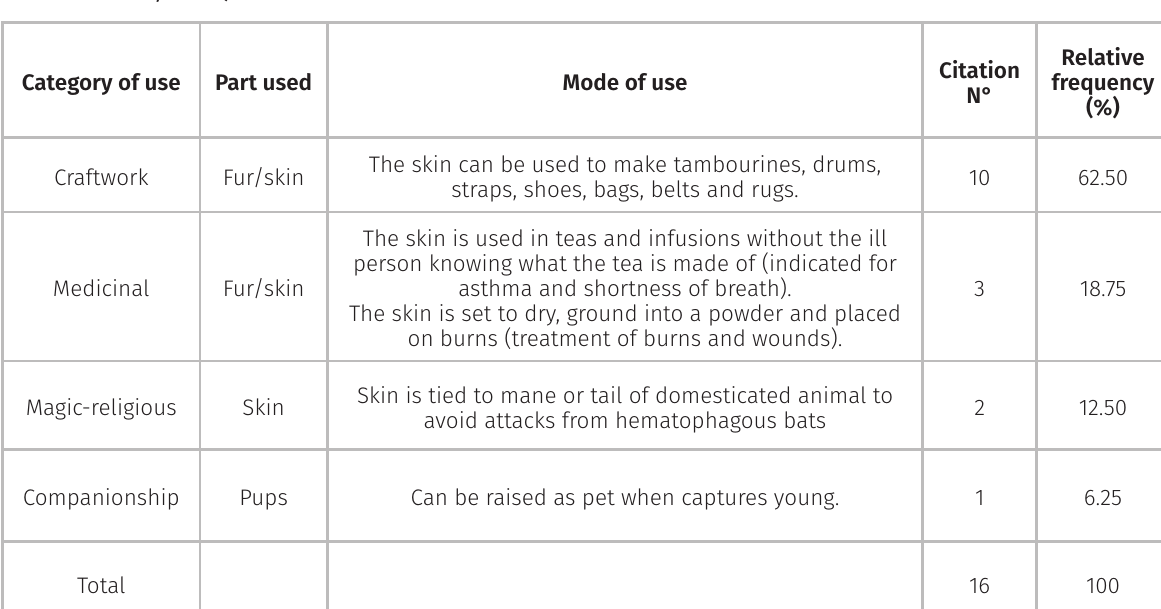
The skin can be used to make tambourines, drums, Fur/skin straps, shoes, bags, belts and rugs. The skin is used in teas and infusions without the ill person knowing what the tea is made of (indicated for Fur/skin asthma and shortness of breath). The skin is set to dry, ground into a powder and placed on burns (treatment of burns and wounds). Skin is tied to mane or tail of domesticated animal to Skin avoid attacks from hematophagous bats Pups Can be raised as pet when captures